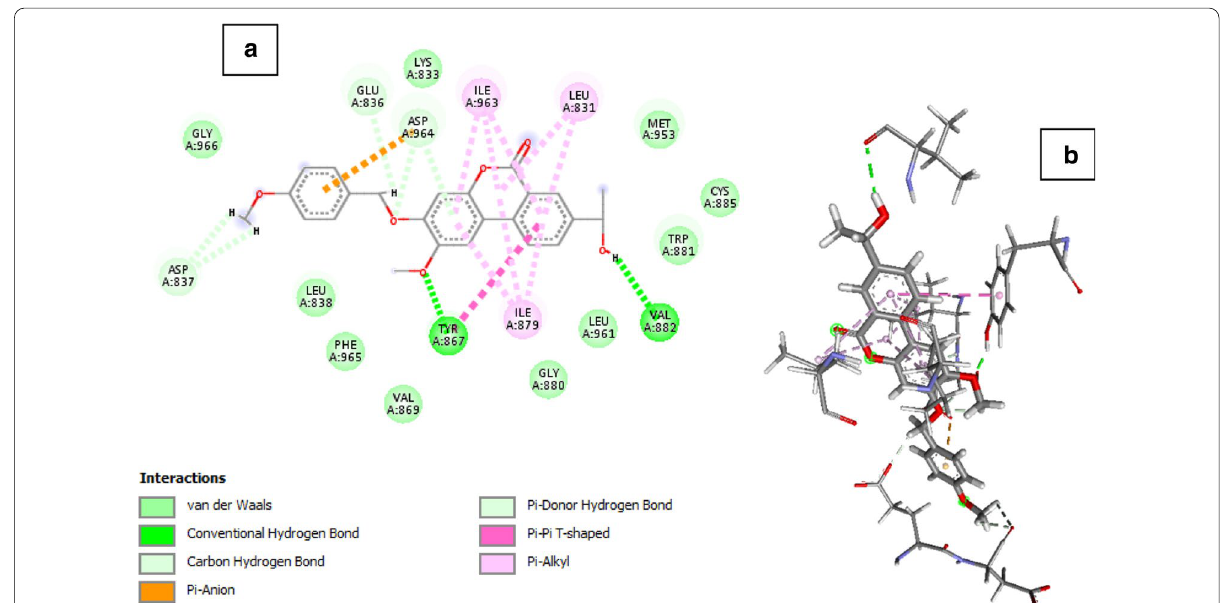
Fig. 7 2D and 3D binding pose interaction of Palomid 529- mTOR kinase complex in a and b respectively. 2D 2dimension, 3D 3dimension